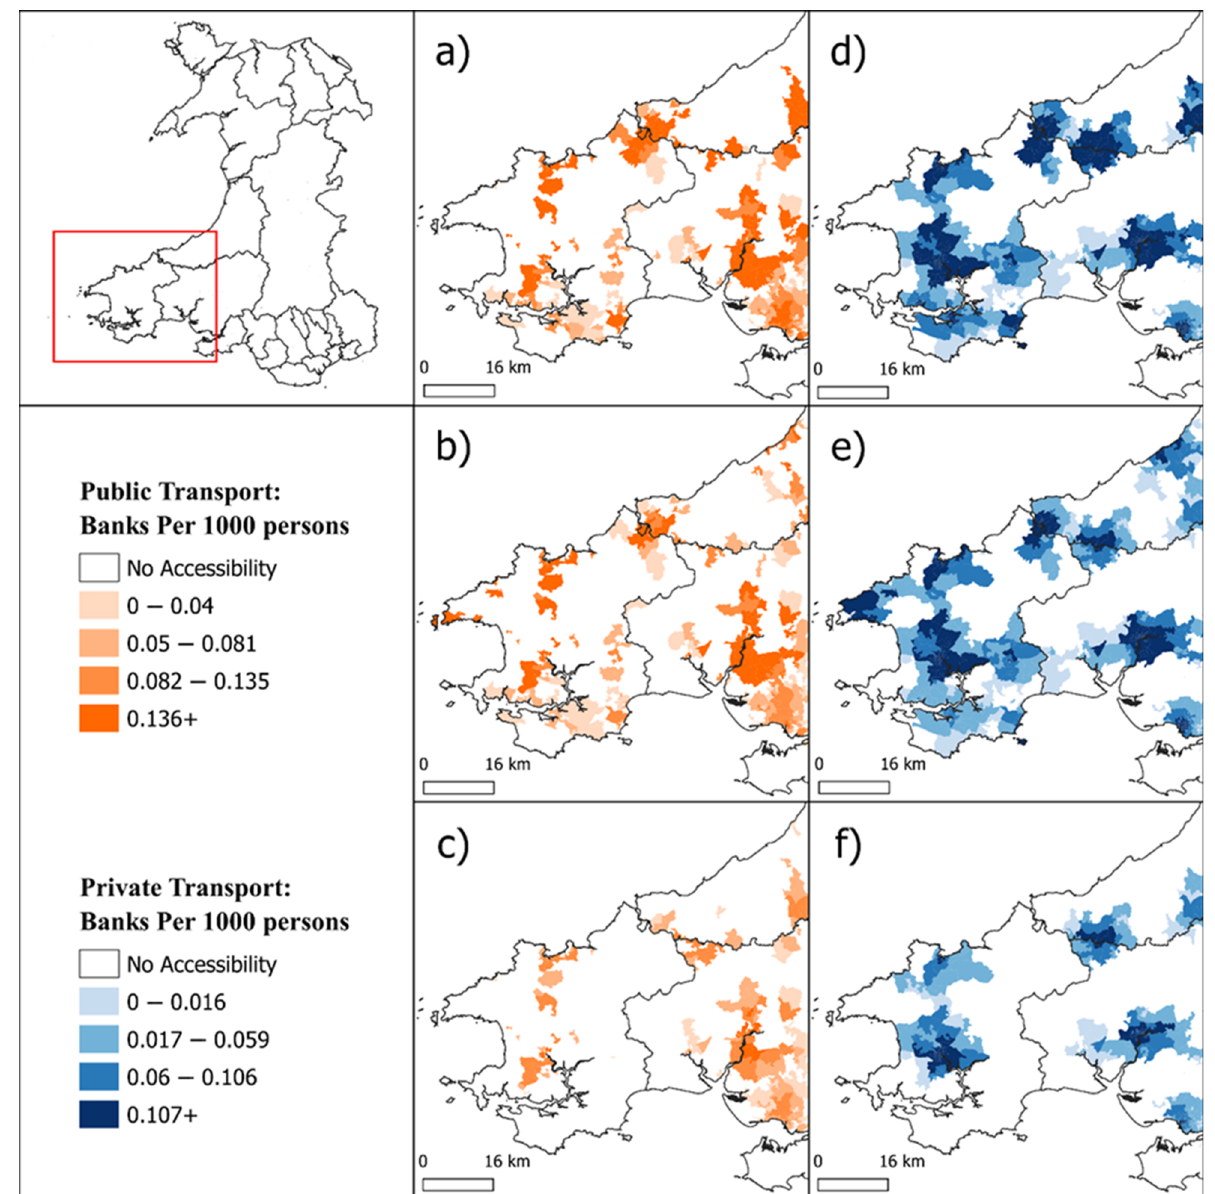
Figure 7. Comparison of FCA scores in the Pembrokeshire peninsular when temporal restrictions relating to travel (bus timetables) and service availability (branch opening hours) are modeled. Series ( a – c ) report access via public transport on Tuesday at 11 a.m., Friday at 2 p.m., and Saturday at 11 a.m., respectively. Series ( d – f ) are equivalent maps based on travel by private